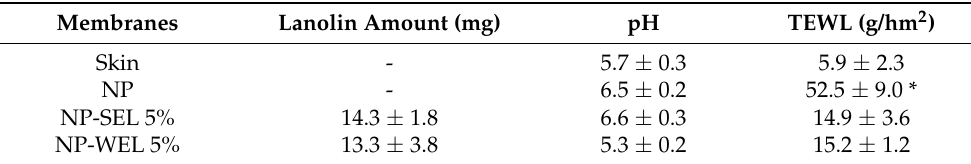
Table 2. Amount of lanoline in lanolin-based membranes, transepidermal water loss (TEWL), and pH of all